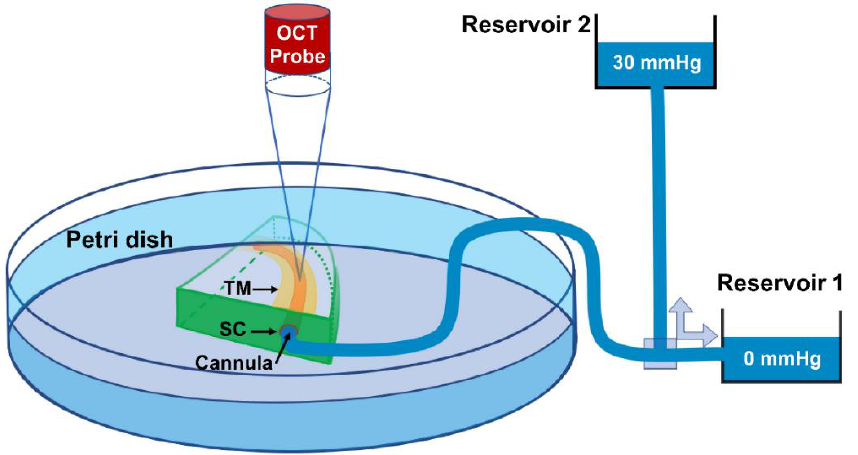
Figure 1. Schematic overview of experimental setup, including the HR-OCT system, two reservoirs used for controlling pressure in SC. HR-OCT B-scan images were acquired continuously through the TM, JCT and SC at 30 Hz, resulting in very high resolution images from which TM/JCT/SC complex motion can be determined in real time